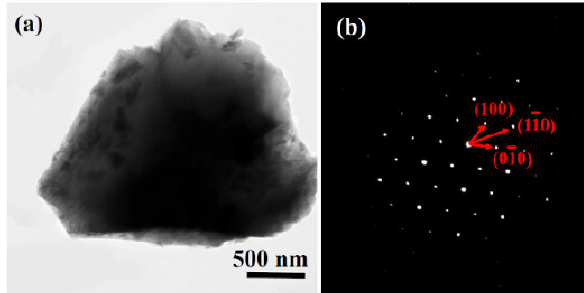
Fig. 3 (a) TEM image and (b) SAED pattern in the transparent part near edge of the Al 4 SiC 4